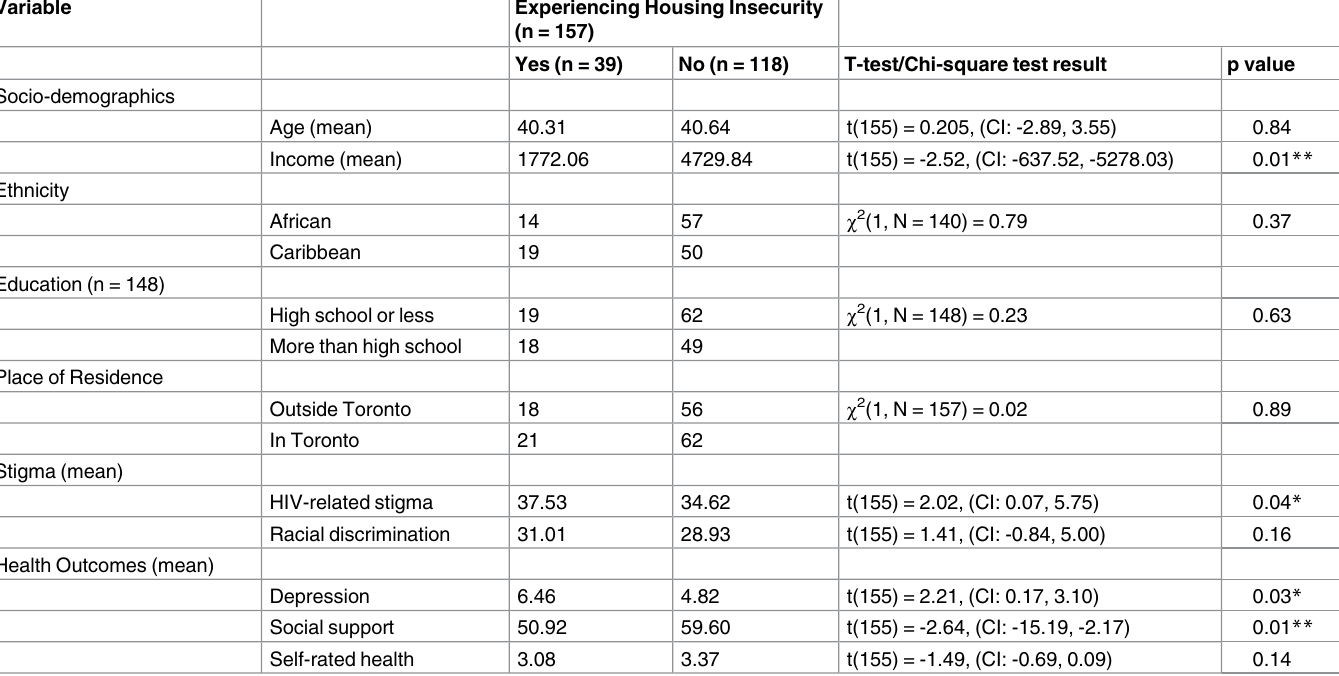
Total sample size = 173, but for these analyses, n = 157 for housing insecurity (unless otherwise specified for ethnicity and education) because of missing data on outcomes of interest; participants were permitted to decline responding to